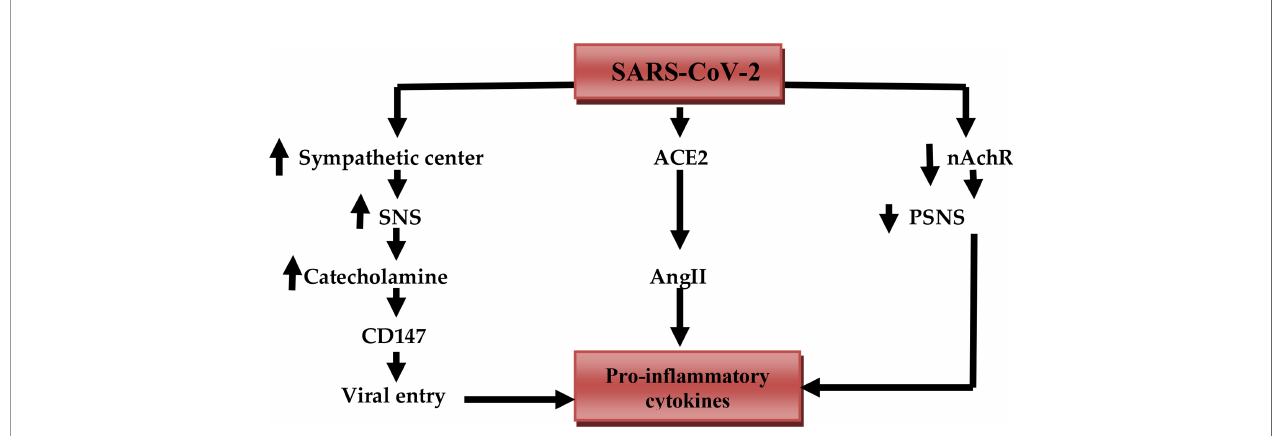
FIGURE 3 | SARS-CoV-2 and release of pro-in fl ammatory cytokines: SARS-CoV-2 activates the sympathetic center, increases activity of the sympathetic nervous system (SNS), the release of catecholamine, which activates the expression of CD147 that increase viral entry. SARS-CoV-2 downregulates ACE2 which increases circulating angiotensin II (AngII). SARS-CoV-2 inhibits anti-in fl ammatory nicotinic acetylcholine receptor (nAChR) with reduced activity of the parasympathetic nervous system (PSNS). These changes together trigger the release of pro-in fl ammatory